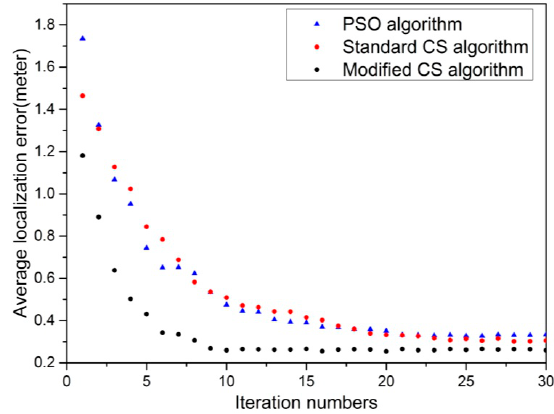
Figure 10. Comparison with standard CS and PSO algorithm.